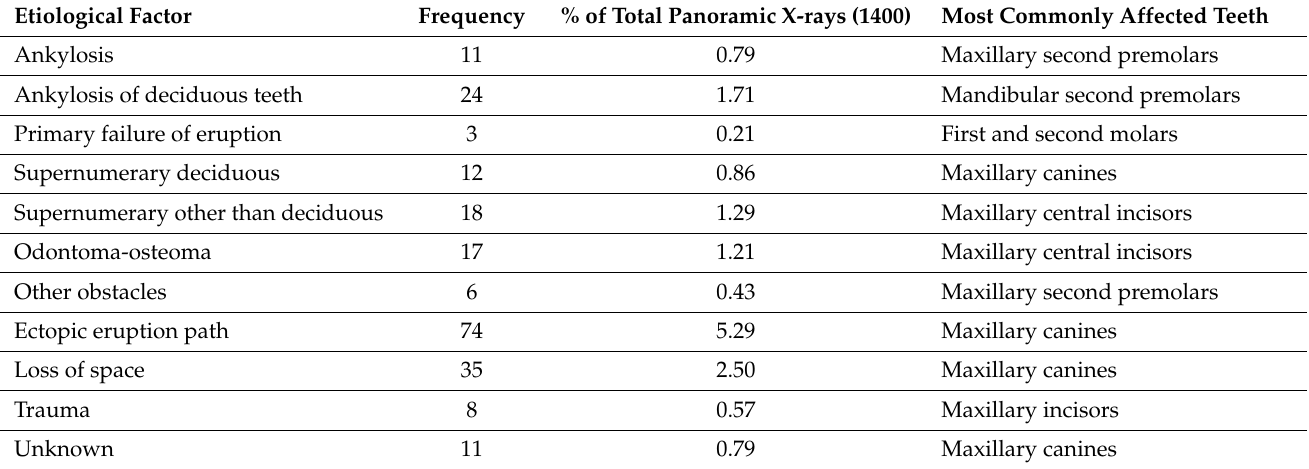
Table 2. Frequency of etiological factors of